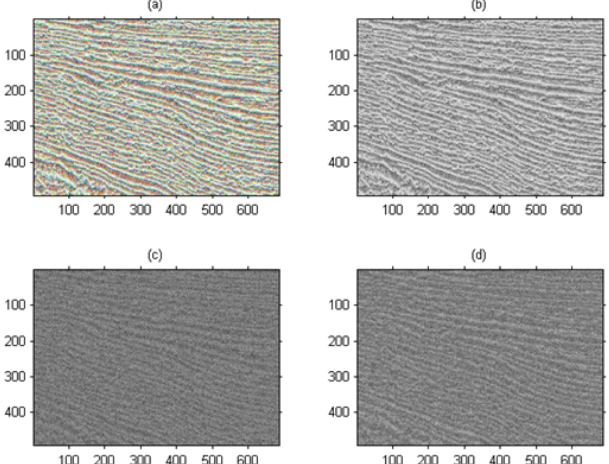
Figure 4. Converting a seismic section image from RGB format to YcbCr format. (a) Original seismic image. (b) The brightness com- ponent Y of the image (a) after the format conversion. (c, d) Chroma component Cb and Cr of image (a) after format